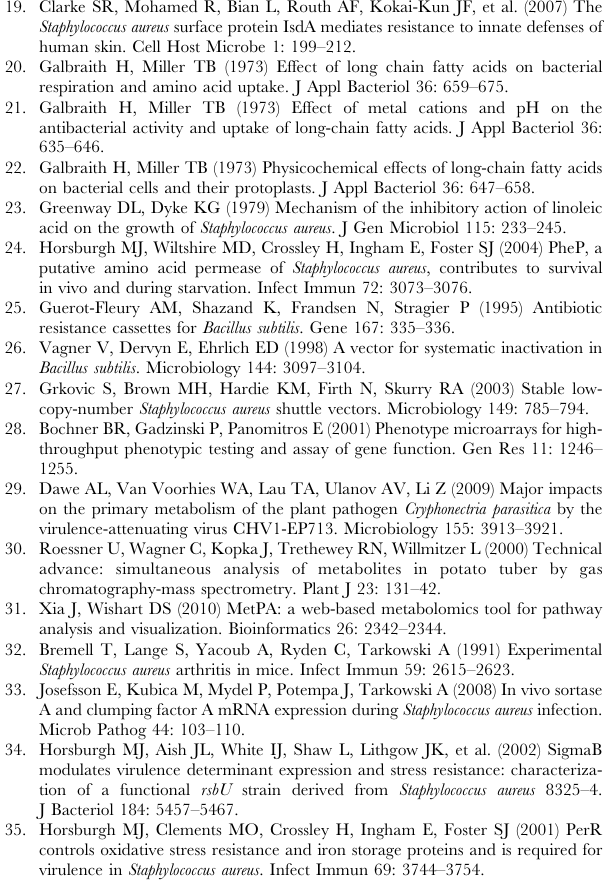
Table S1 Metabolites present in S. aureus strains. Metabolites were identified using GC-MS analysis of cytoplasmic fractions from exponential growth phase cells. 131 unique metabolites were compared and chromatograms and mass spectra were evaluated as described previously [8,32] using the MSD ChemStation (Agilent, Palo Alto, CA, USA) and AMDIS (NIST, Gaithersburg, MD, USA) programs. The resulting data from triplicate samples (with less than 10% variability) were analyzed using a t-test. Samples with greater than 2-fold variation (p , 0.05) were analyzed using the MetPA enrichment pathway analysis